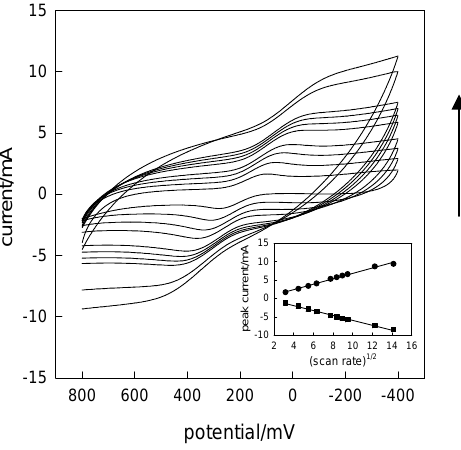
Figure 3. Cyclic voltammograms obtained with the CLTNPE in 0.1 mol·L -1 KCl containing 20 m mol·L -1 potassium ferricyanide (pH 7.0). From down to up, the scan rate